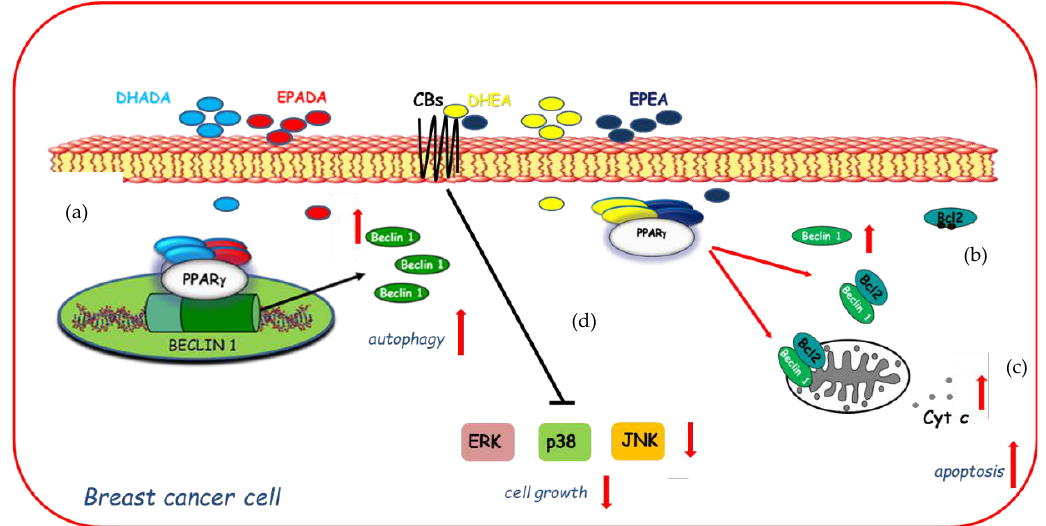
Figure 3. Molecular mechanisms by which docosahexaenoic acid (DHA)- and eicosapentaenoic acid (EPA)-conjugates upregulate Beclin-1 expression in a transcriptional-dependent ( a ) and -independent ( b ) manner through peroxisome proliferator activated receptor gamma (PPAR γ ) activation promoting autophagy in breast cancer cells and subsequently apoptosis ( c ) as evidenced by cytochrome c release (Cyt c ) from mitochondria to the cytosol. In addition, DHEA and EPEA by binding to cannabinoid receptors (CBs) elicit changes in mitogen-activated protein kinase (MAPK) signaling ( d ) by decreasing activation of ERK (Extracellular Signal-regulated Kinase), p38 MAPK (Mitogen-Activated Protein Kinase), and JNK (c-Jun N-terminal kinase) MAPK pathways inducing cell growth inhibition.